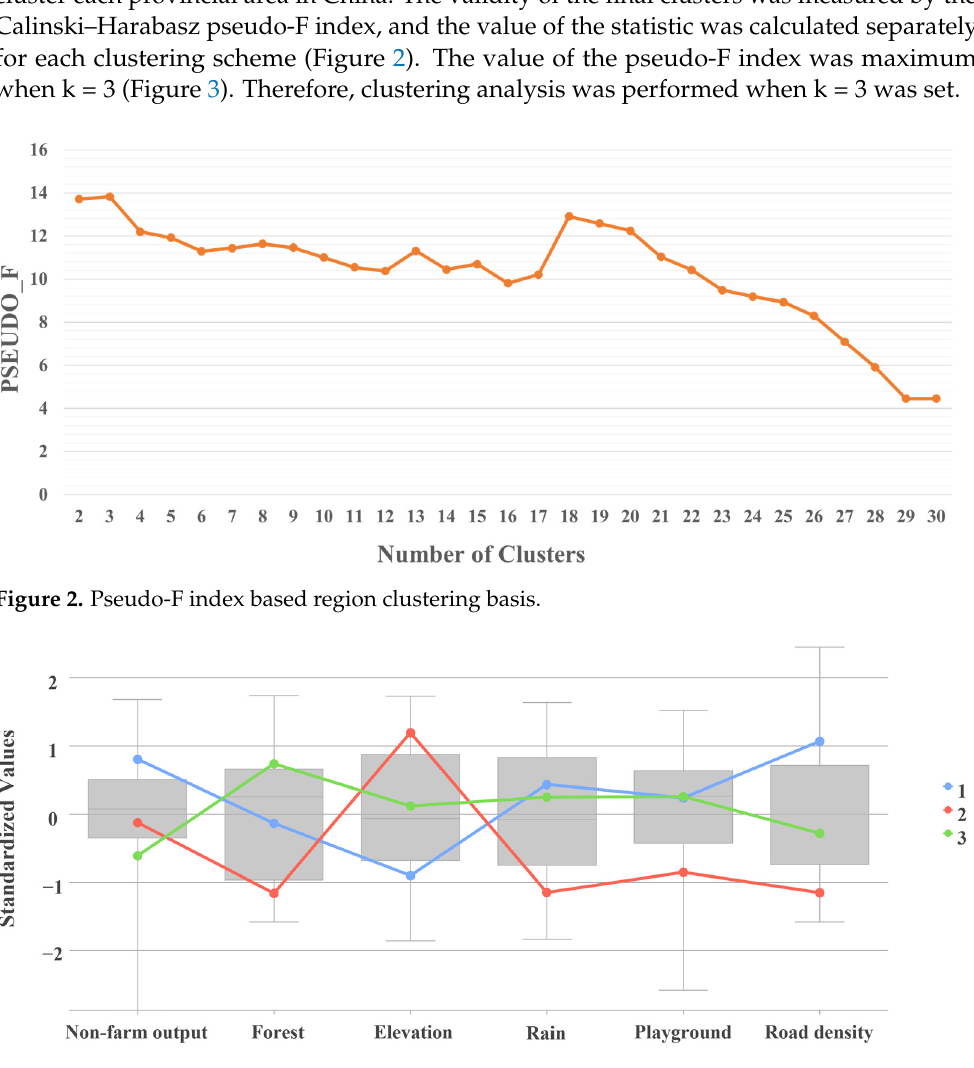
Figure 3. Standardized multivariate clustering boxplots.